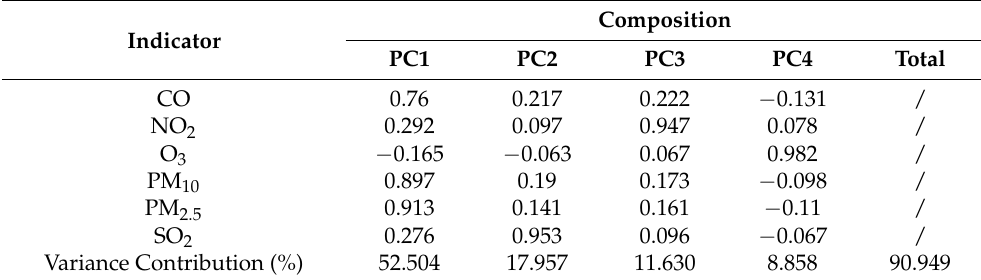
Table 2. Composition matrix table after rotation of pollutant